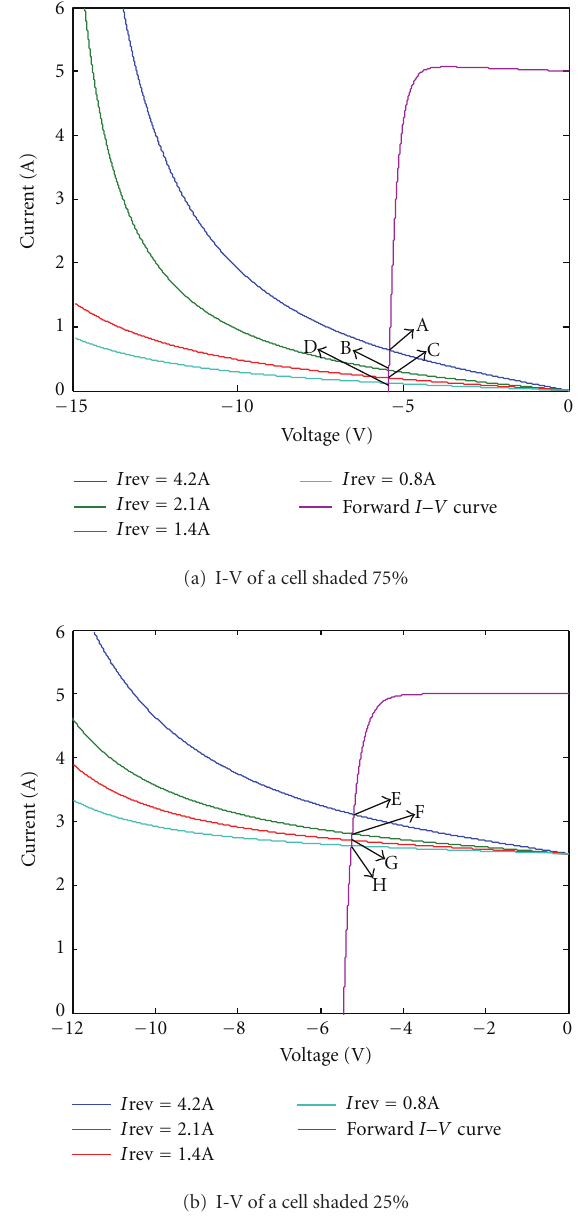
Figure 6: The I-V characteristics of module with a shaded